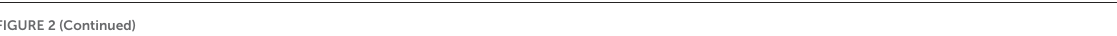
Electromyography (EMG) examination is considered generalized myopathic damage. No special treatment was